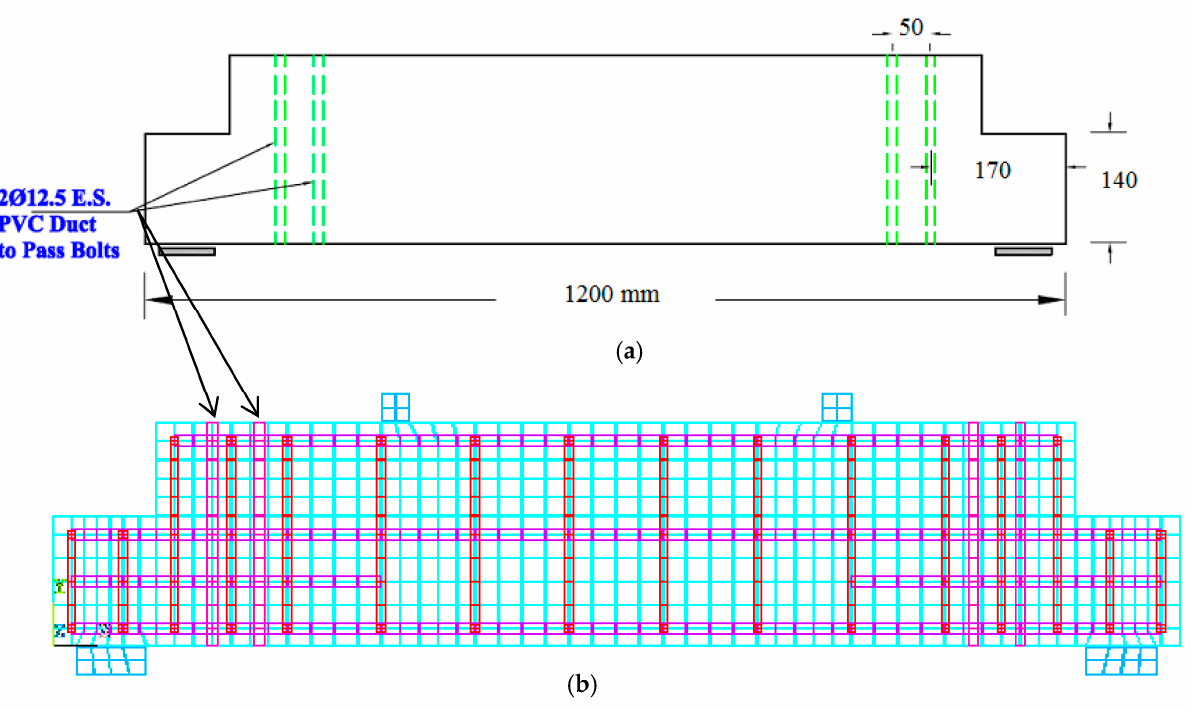
Figure 6. Experimental details and numerical simulations of model DET5. ( a ) Geometry layout in the previous experimental investigation [39]. ( b ) Numerical modelling.